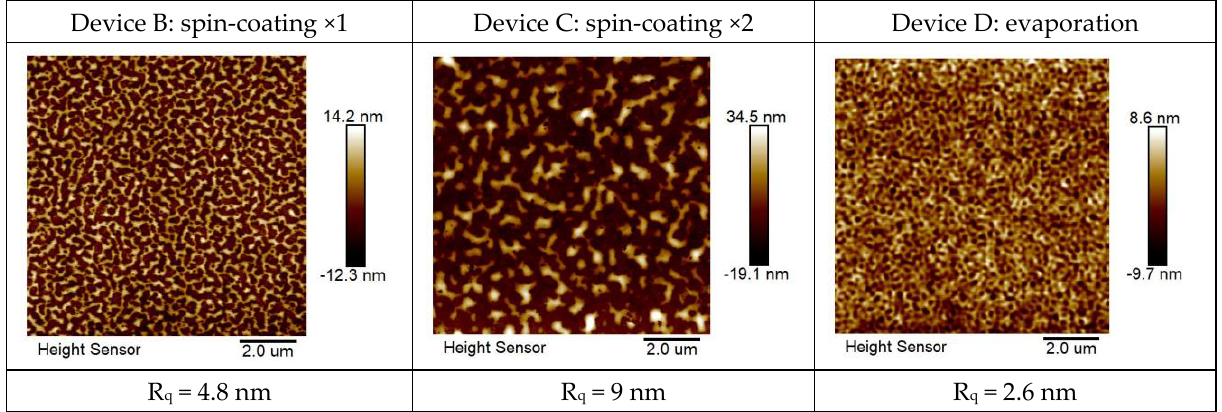
Figure 3. AFM film morphology for the EML of devices B, C, and D, respectively.